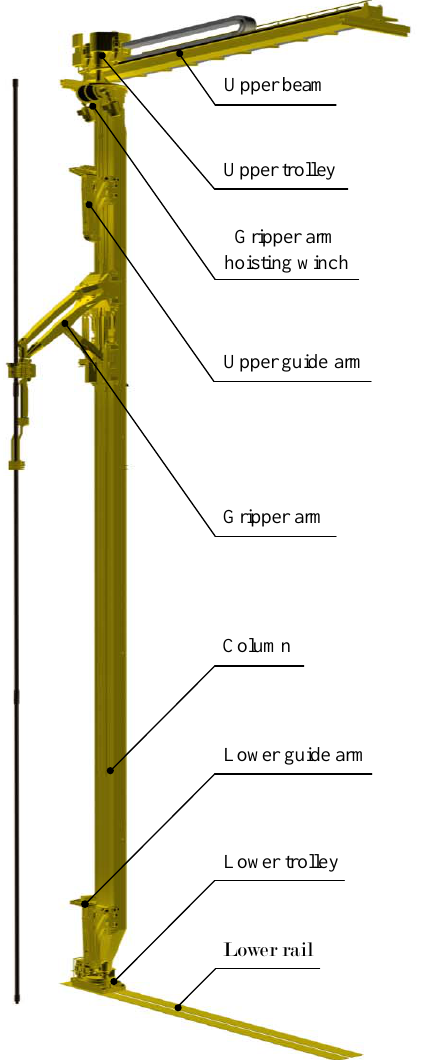
Figure 3: Illustration of the SmartRacker - courtesy of Cameron Sense